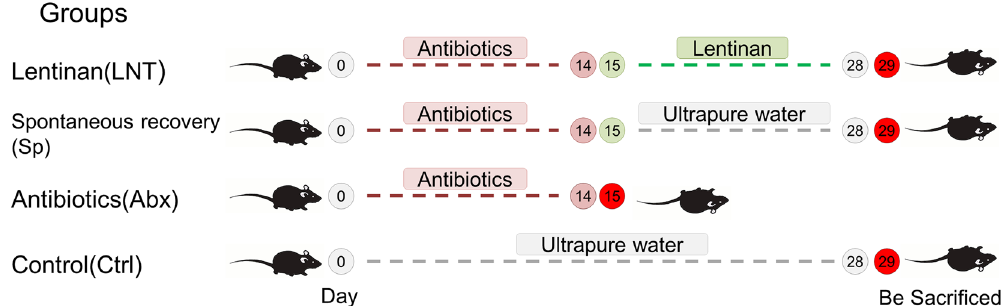
Figure 1. Experimental design of the study. Experimental plan outline where the control group (Ctrl, n = 5) received 200 μl/12 h ultrapure water from days 1 to 14 and 200 μl/24 h ultrapure water from days 15 to 28. The antibiotics groups (Abx, n = 5) received broad-spectrum antibiotics solution from days 1 to 14 and were sacrificed on day 15. The spontaneous recovery group (Sp, n = 5) received broad-spectrum antibiotics solution from days 1 to 14 followed by 200 μl/24 h ultrapure water from days 15 to 28 to observe spontaneous recovery. The lentinan group (LNT, n = 5) received broad-spectrum antibiotics solution from days 1 to 14 followed by lentinan treatment from days 15 to